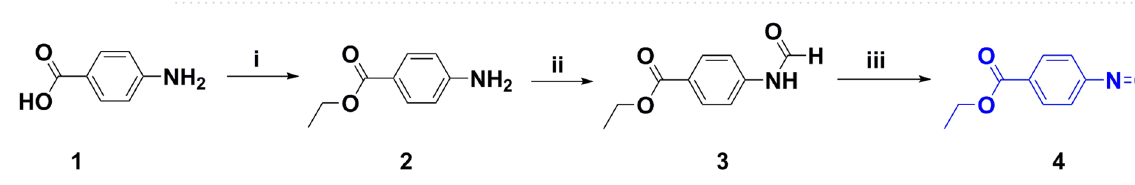
Figure 3. Synthesis of ethyl-4-isocyanobenzoate 4